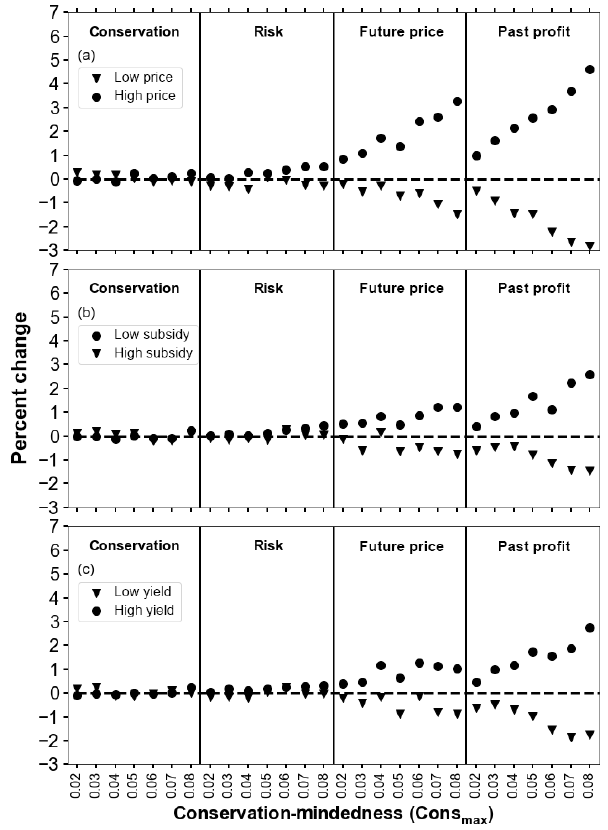
Figure 11. Percent change in median 90th percentile discharge from the historical scenario for (a) high and low crop prices, (b) high and low subsidies, and (c) high and low yields for the conservation, risk, future price, and past profit weighting